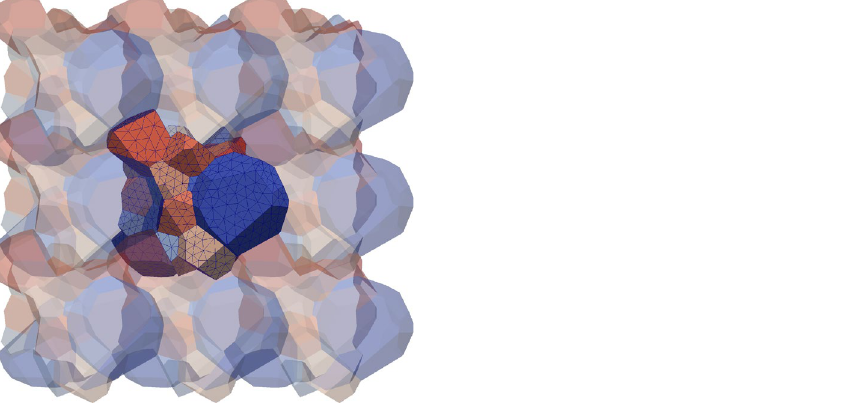
Figure 2. Periodic grain structure with periodic FEM mesh created with neper .